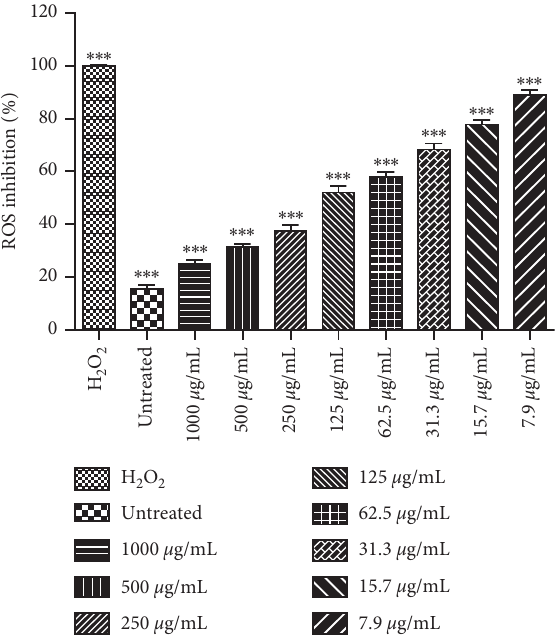
Figure 3: Intracellular ROS inhibitory levels were measured by fluorescent probe DCF-DA in SH-SY5Y cells pretreated with ex- tract for 24hrs and challenge with H 2 O 2 (150 mM) to induce ROS production. The values represent mean ± SD from three inde- pendent experiments. ∗∗∗ p < 0 . 001 represented significantly dif- ferent values from H 2 O 2 treated group and the group that are treated with crude extract (7.9–1000 µ g/mL) followed by exposure to H 2 O 2 .